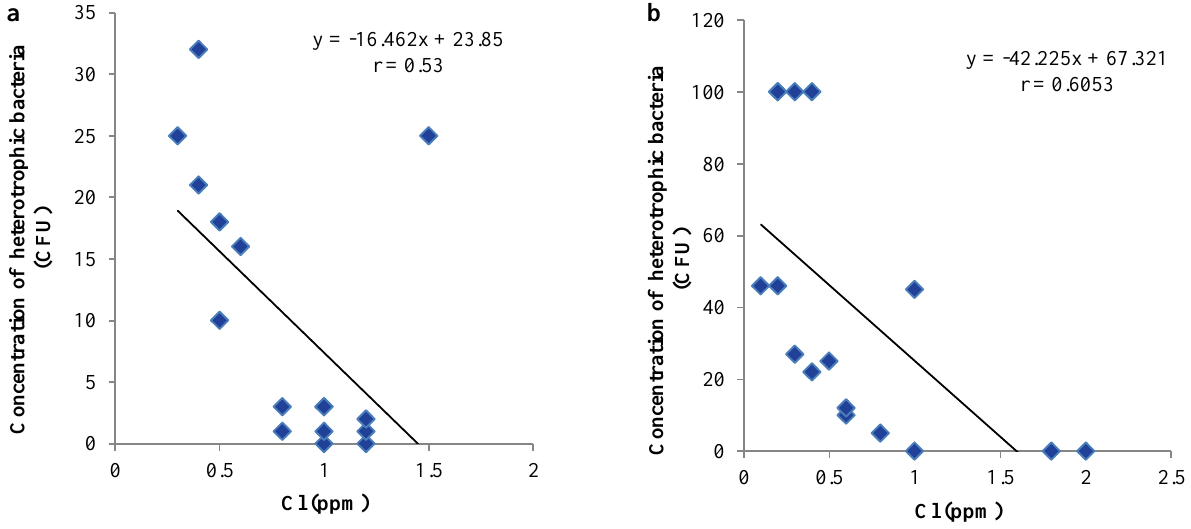
Figure 4. Scatter plot comparing heterotrophic bacteria concentration in the (a) new and (b) old distribution